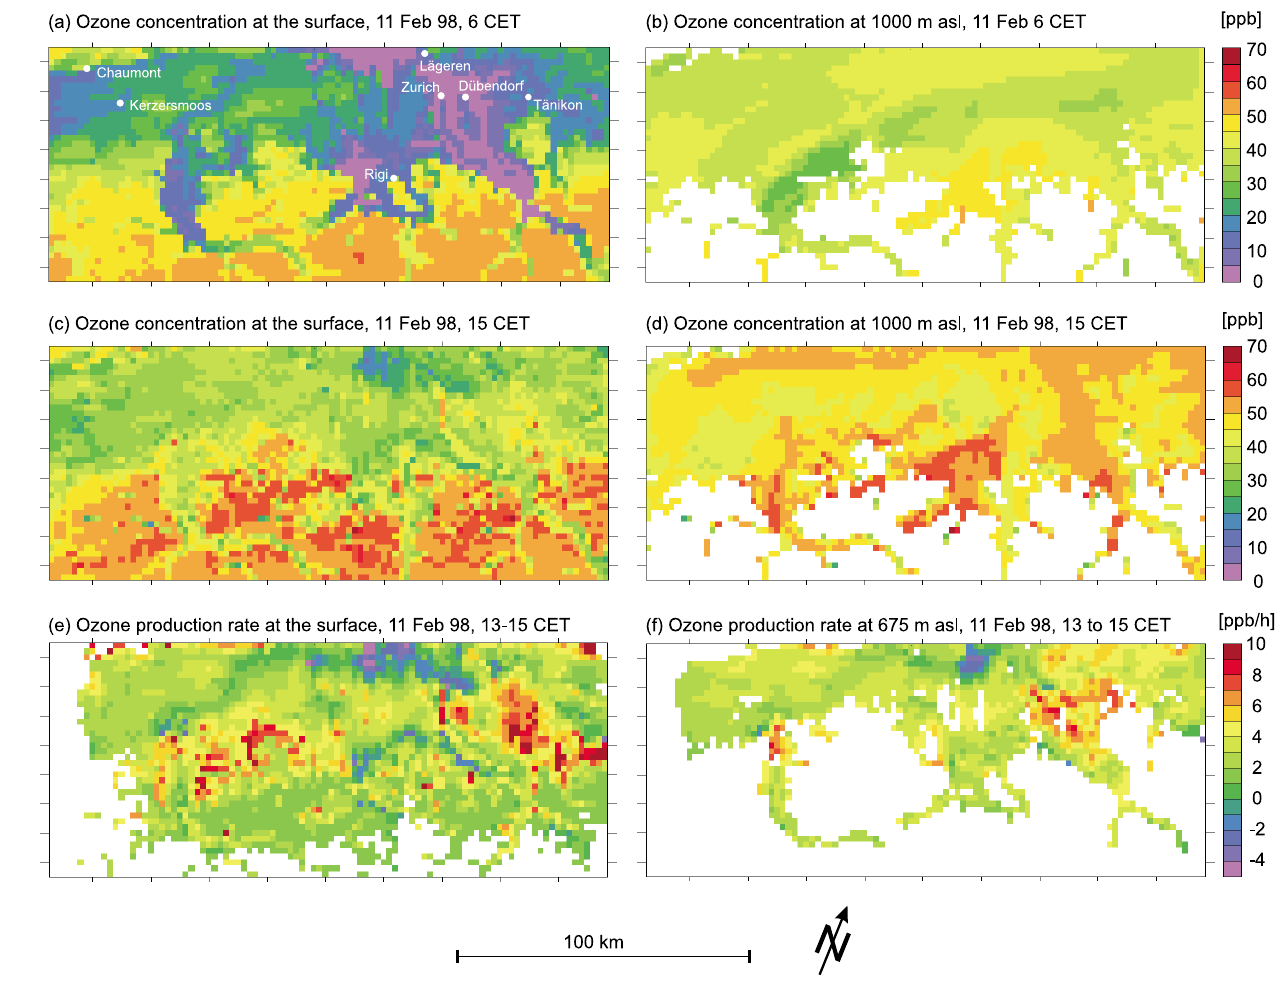
Fig. 9. Ozone concentration fields modelled by Metphomod for 11 February, 6 CET at the surface (a) and at 1000 m asl (b) , and on 11 February 15 CET at the surface (c) and at 1000 m asl (d) . Average ozone production rate in the “Pseudo-Lagrangian” framework for the last 2 hours at the surface (e) and at 675 m asl (f) , for air parcels at 11 February 16 CET. The outermost two grid cells on all sides were deleted in all charts. White spots are below